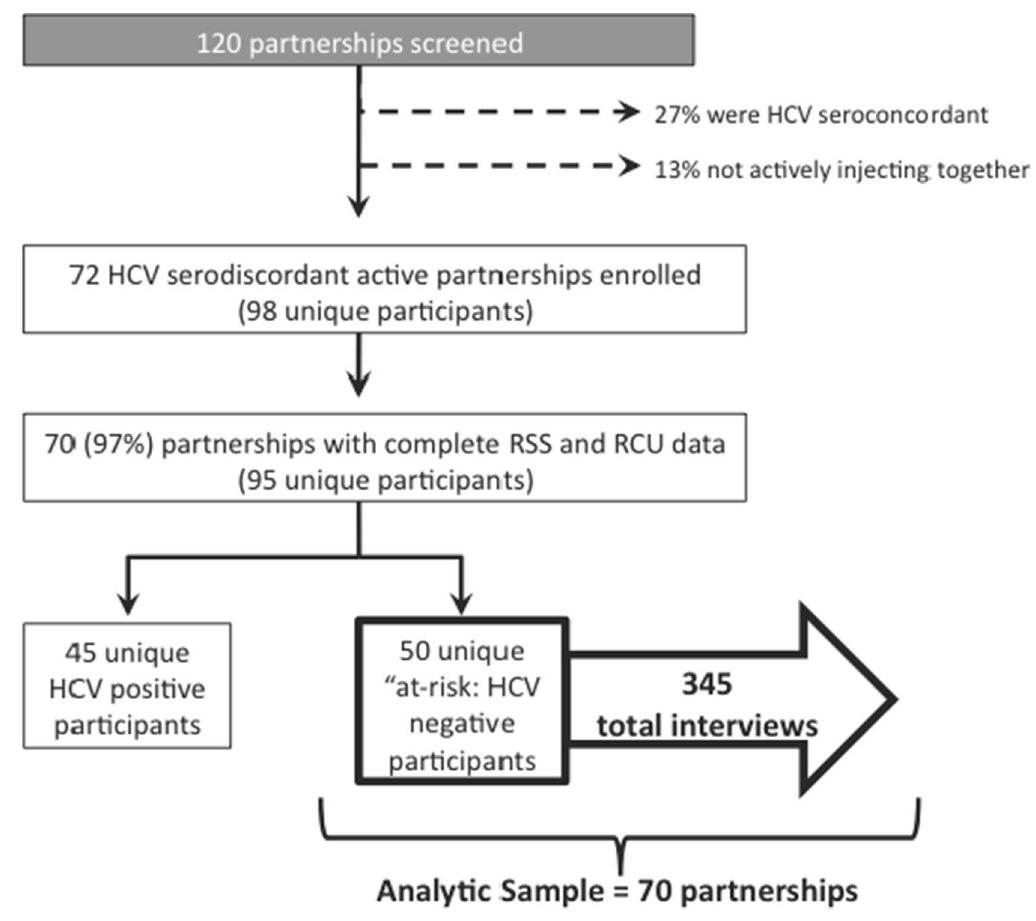
Figure 1. Flow chart of total study population and analytic sample.